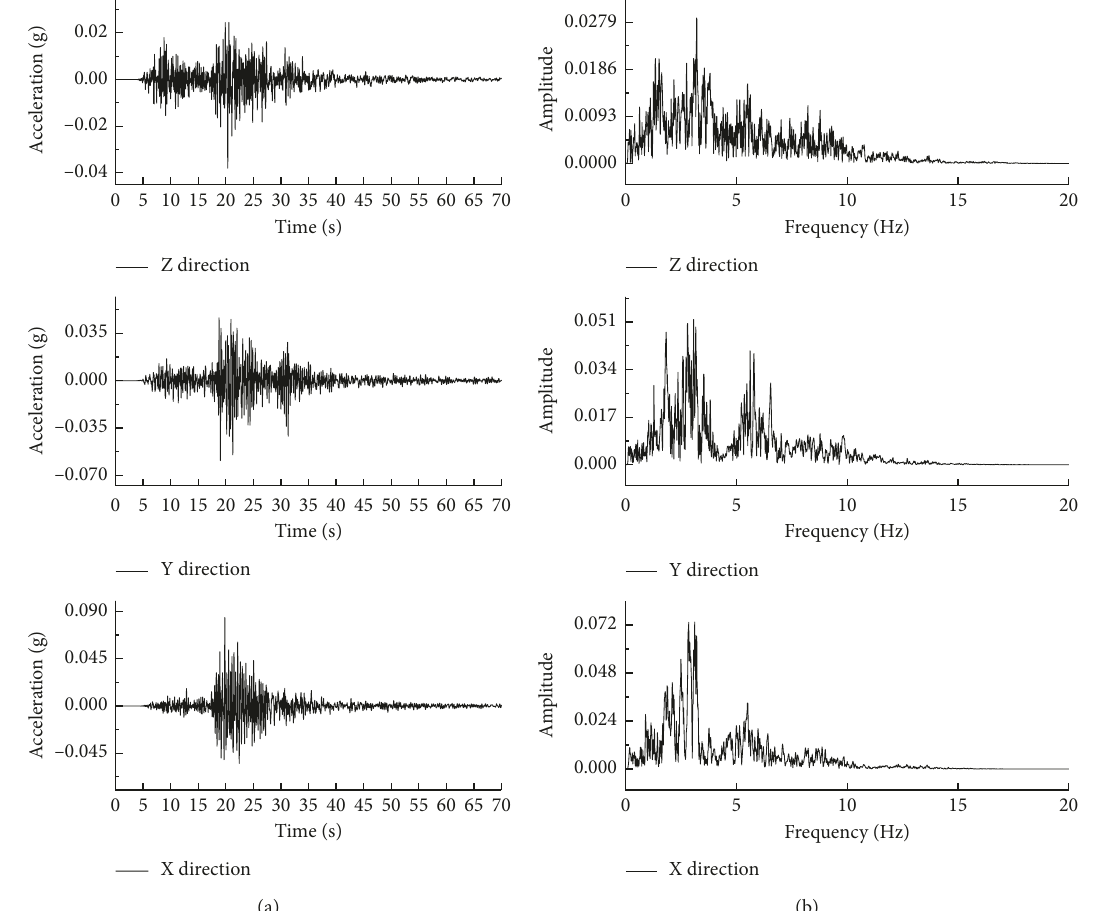
Figure 6: Acceleration time history and Fourier spectrum of records Kobe